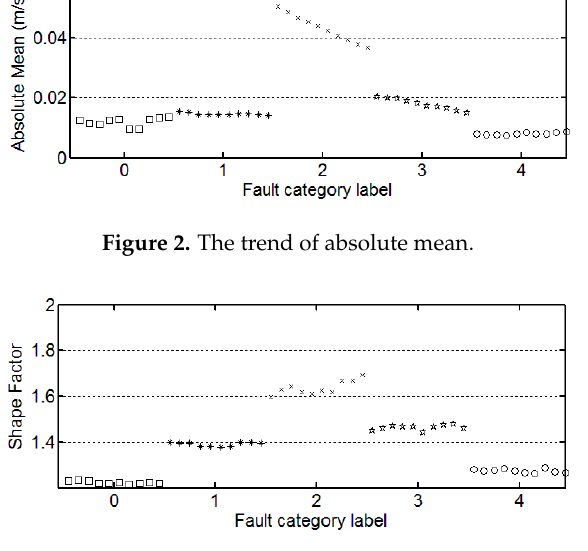
Figure 3. The trend of shape factor.